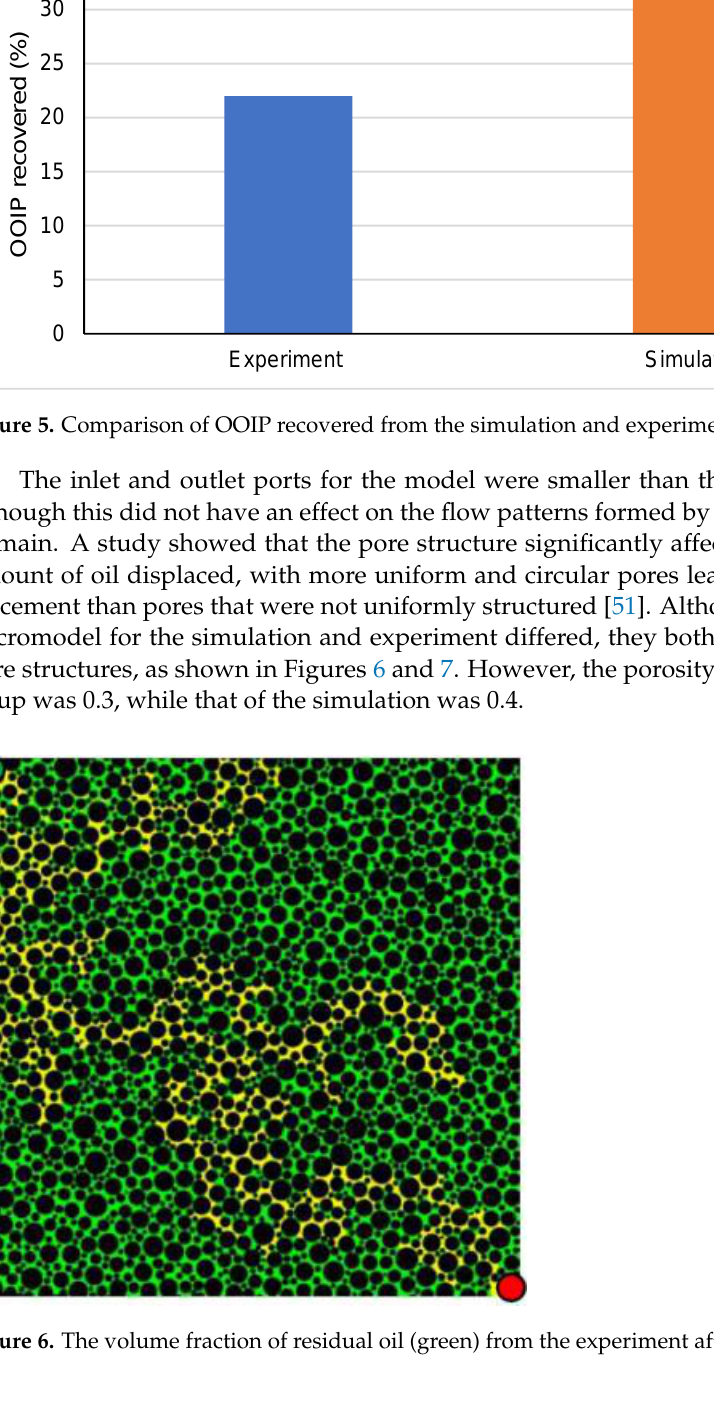
Figure 7. The volume fraction of residual oil (blue) from the simulation after breakthrough. 3.3. Inlet Pressure Profile Figure 8 shows the pressure at which the APG was injected into the micromodel for cases 1, 2, and 3. Along the profile of the micromodel, the inlet pressure decreased for all three cases. At the beginning of the simulation, the pressure was high and dropped sharply as the simulation progressed, levelling off at atmospheric conditions. Figure 8. Inlet pressure of injected APG against time.